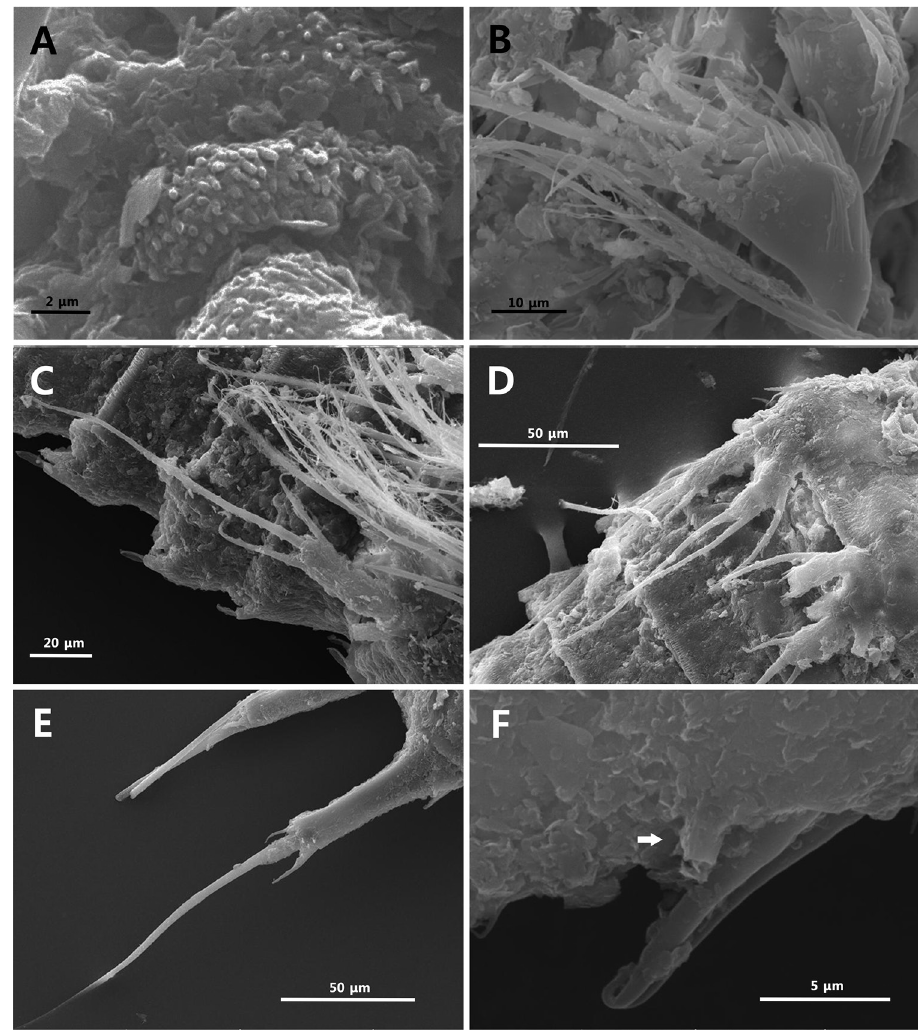
Figure 9. Scanning electron microscope photographs. Strongylacron glabrum sp. n. female: A surface of antennules, dorsal B antennary endopod C, D P5 E caudal rami F caudal setae I, II and tube pore